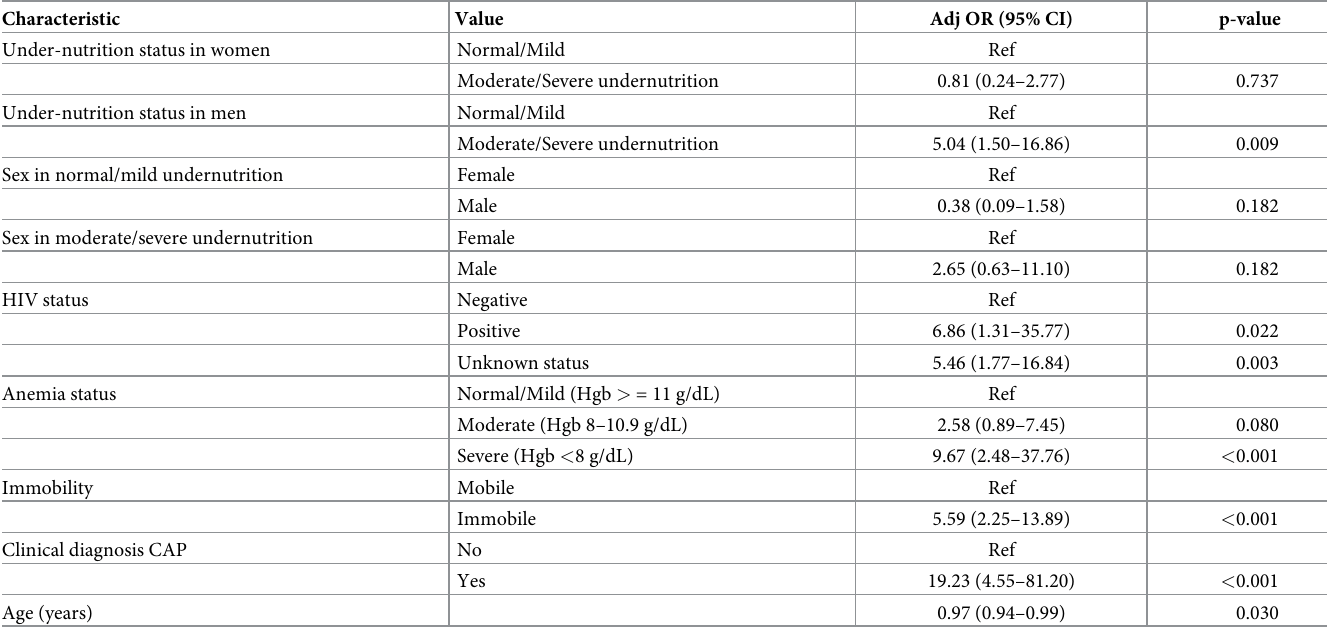
Table 3. Multivariable analysis of D3-D28 mortality in all admitted patients (N =